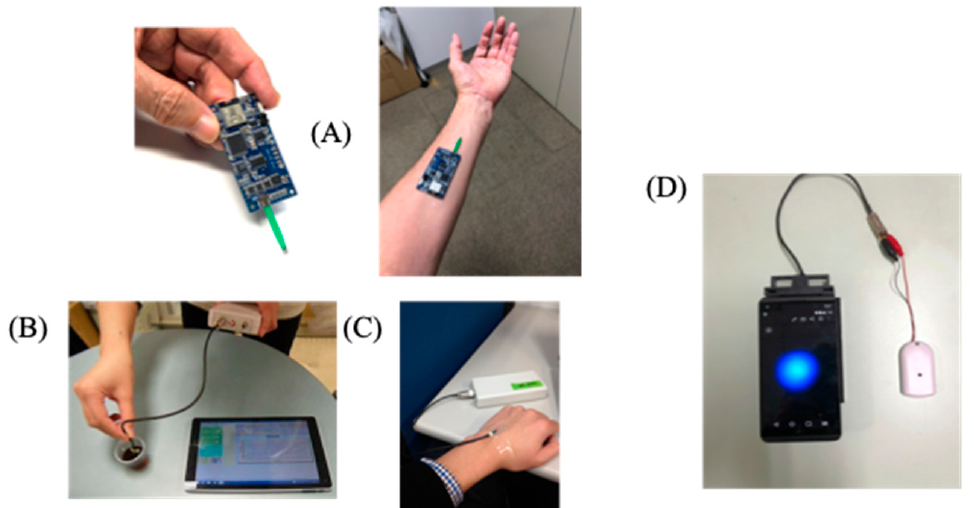
Figure 1. Electrochemical devices with compact, lightweight, wearable wireless capability. ( A ) One board electrochemical (EC) device with wireless communication by Bluetooth; ( B ) On-site electrochemical monitoring with the portable EC device; ( C ) Wearable monitoring sweat lactate on the skin; ( D ) Smartphone based electrochemiluminescence measurement.